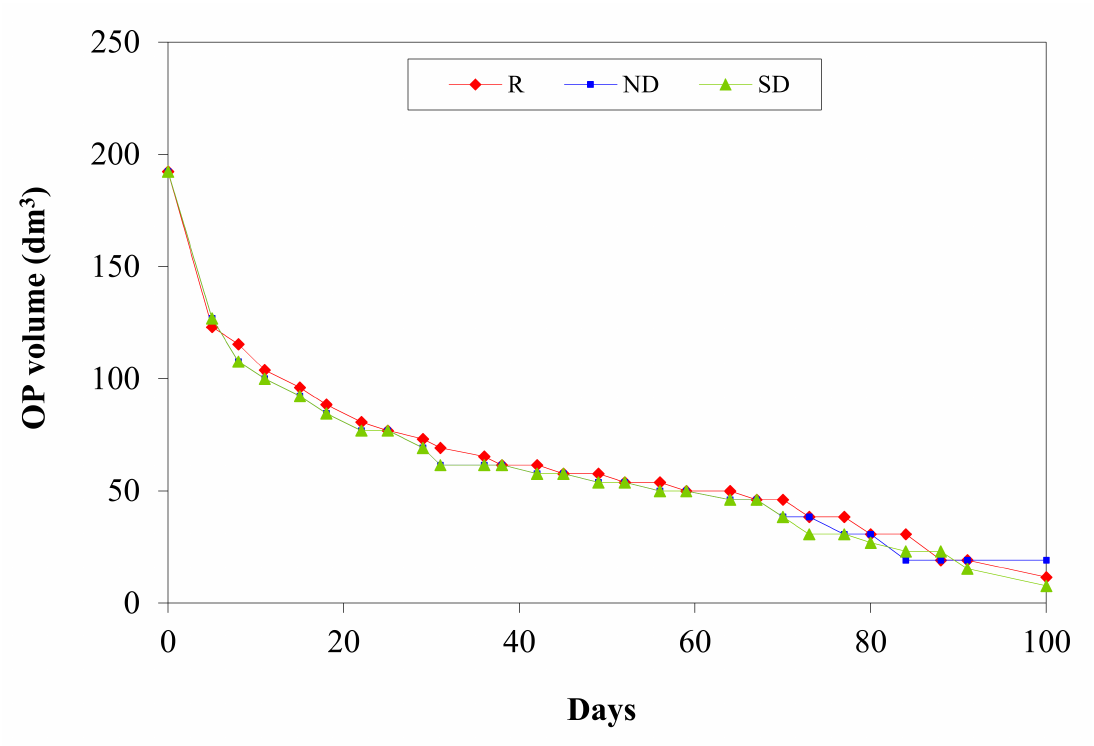
Figure 2. Temporal variation of OP volumes in the lysimetric tests (R, raw OP; ND, naturally drained OP + rainfall; SD, solar-dried OP + rainfall).